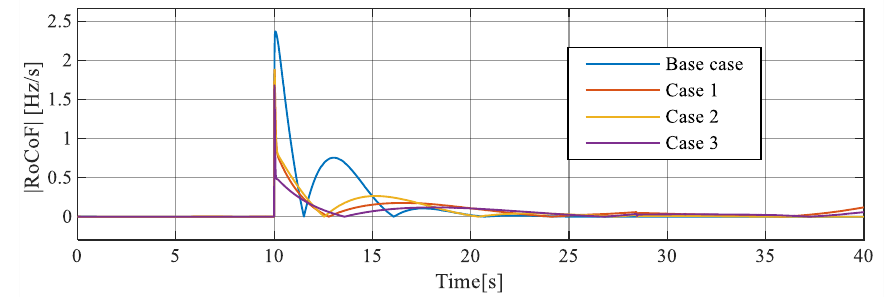
Figure 11. Grid-frequency response to a sub-frequency event.